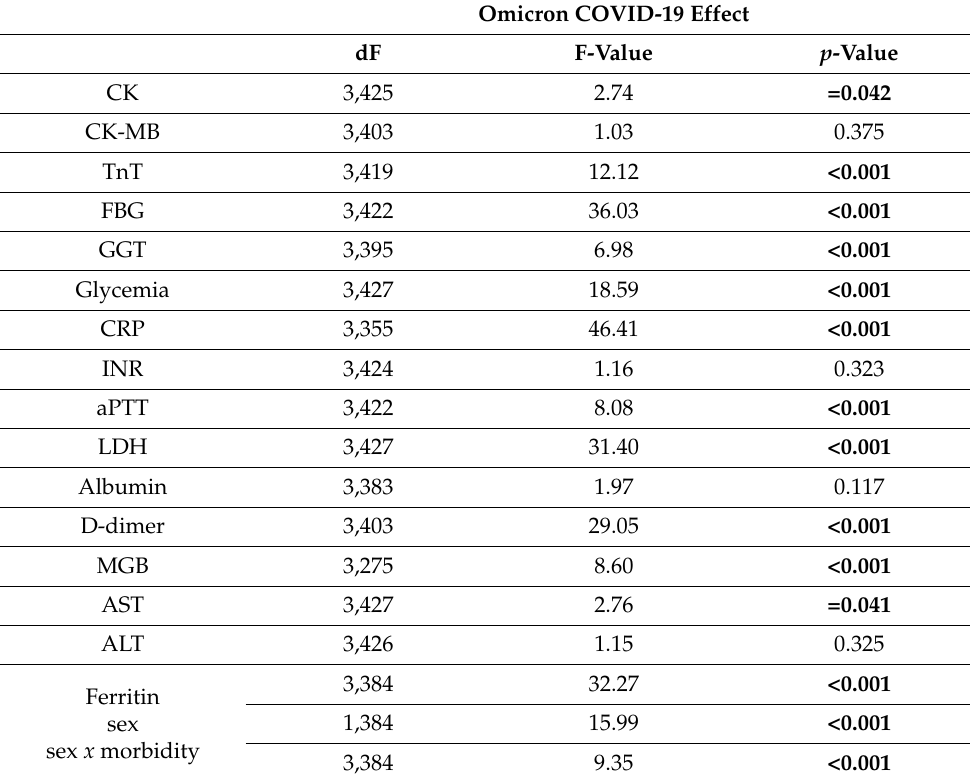
Figure 9. Vaccination effects on LDH and TnT (see Section 3). The error bars indicate pooled stand ‐ ard error means (SEM) derived from the appropriate error mean square in the ANOVA. The aster ‐ isks (* p < 0.05) indicate post hoc differences between groups.